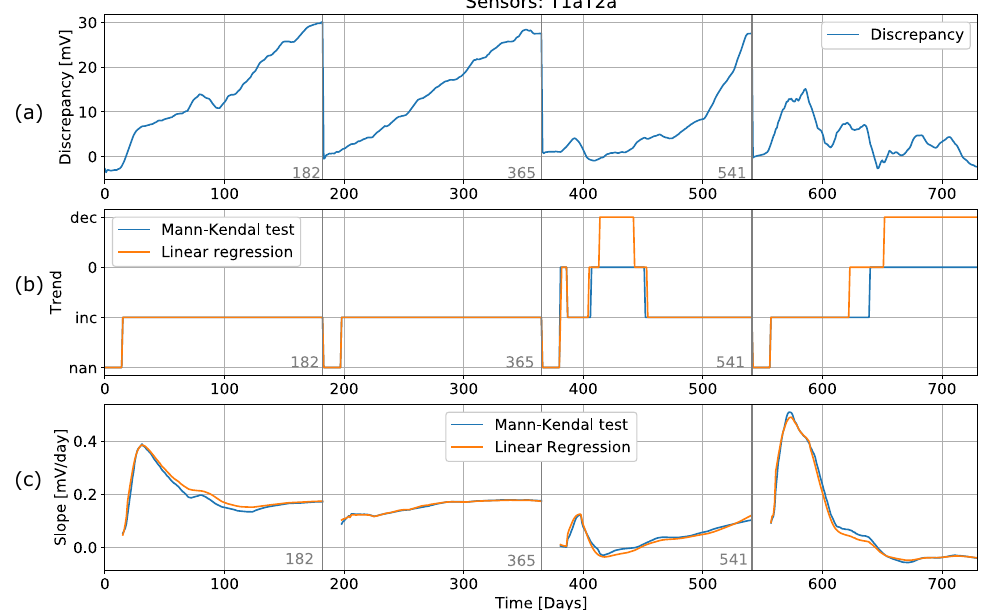
Figure 11. Recursive process of trend detection with filtered (Hampel filter) and averaged (window = ten) data. The graphs show ( a ) processed data ( b ), trend detection, and ( c ) the slope calculated when applying trend detection